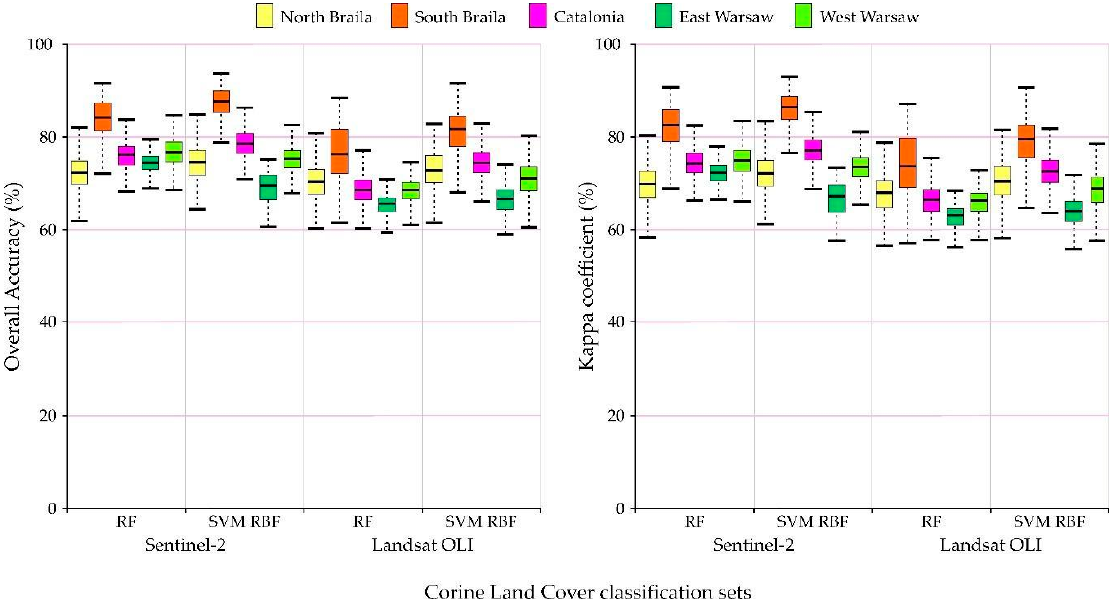
Figure 13. Overall accuracies and Kappa coefficients achieved from used classification sets and algorithms.